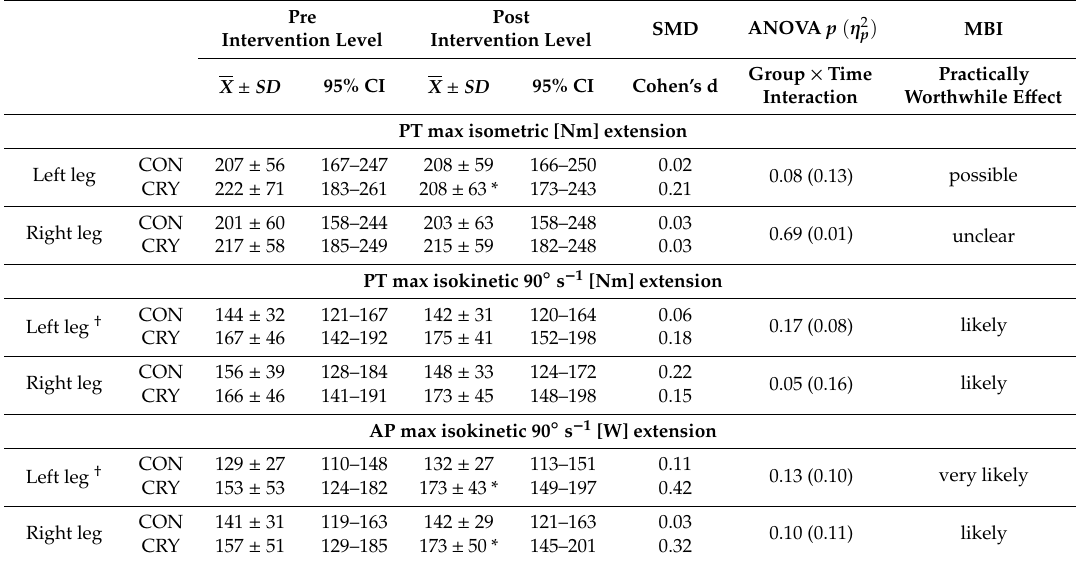
Table 2. The e ff ect of 4 weeks of resistance training combined with di ff erent recovery procedures on extension maximal isometric and isokinetic